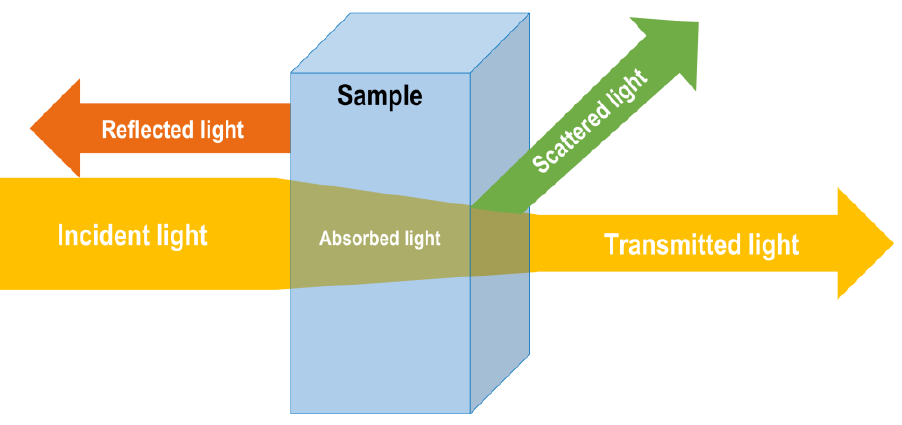
Figure 2. Energy of incident light and phenomena occurrence when interacting with a sample.